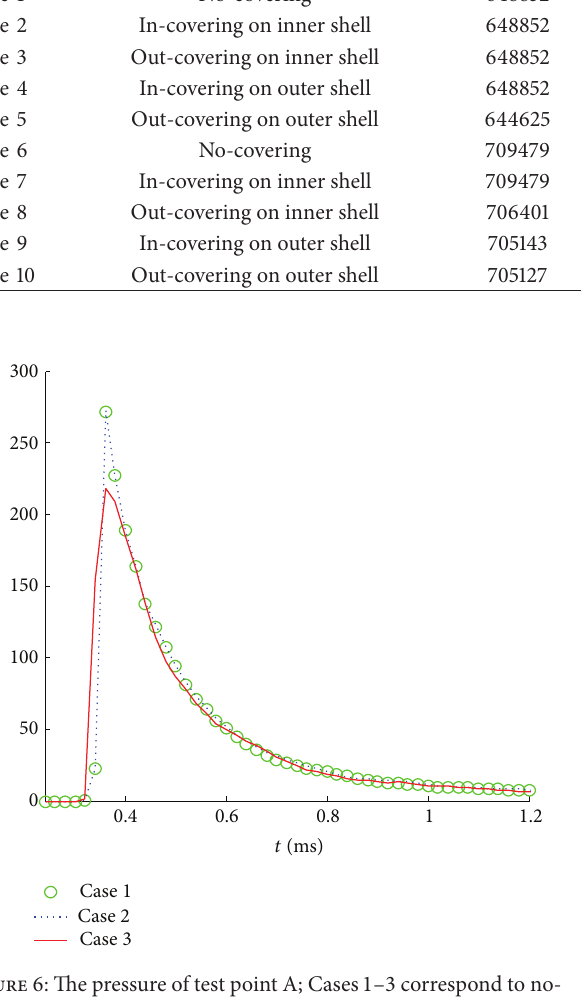
Figure 7: The pressure of test point A in the cases of in-covering with different covering thicknesses; 𝐶 is covering